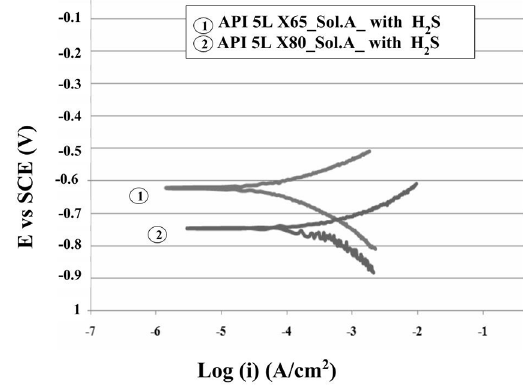
Figure 11. Potentiodynamic polarization curves for the API 5L X65 and API 5L X80 steels after 24h immersion in deaerated solution A, NACE TM0284 (2011), saturated with H S, sour medium. In 2 the diagrams the main anodic and cathodic reactions are indicated. Procedure 2. Table 4. Table with information extracted from the polarization curves after 24h of immersion, Figure 11. Procedure 2. EcorrV Condition